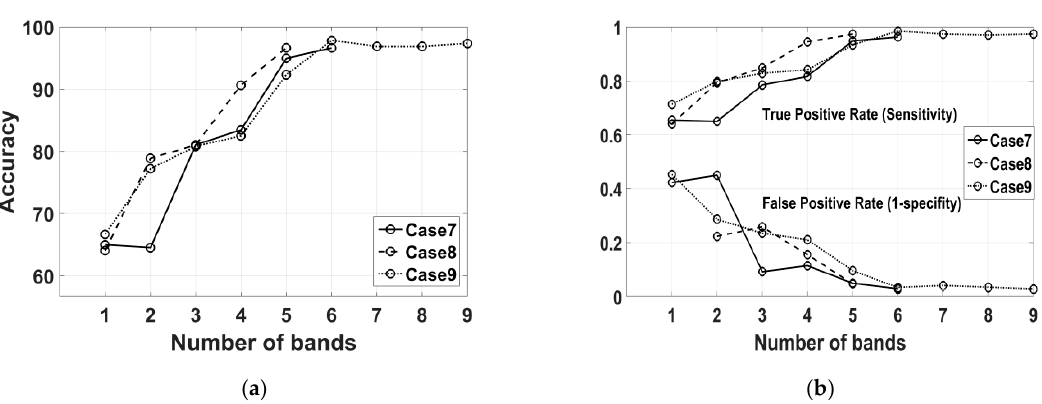
Figure 5. Performance measures in increasing order of adding the selected bands for cases 7–9: ( a ) classification accuracies, ( b ) the TPR and FPR rate. Table 5. Average results of 100 iterations using normalized ratio indexes as the features.